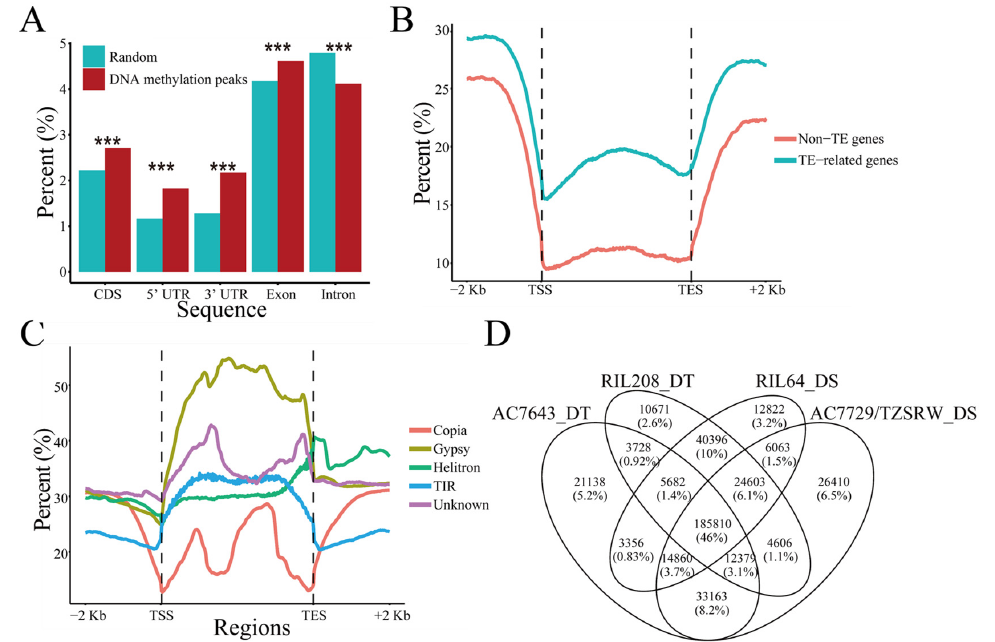
Figure 1. Summary of DNA methylation peaks. ( A ) The proportions of peaks in different genetic elements. The Y axis represents the proportions of random DNA segments and DNA methylation peaks in genetic elements. ***: p < 0.001, χ 2 test. ( B ) The distribution pattern of DNA methylation peaks around the TSS (Transcription Start Site) and TES (Transcription End Site). Non-TE genes: genes without TE-overlapping; TE-related genes: genes overlapped TE. ( C ) The distribution of DNA methylation peaks around the TSS (TE Start Site) and TES (TE End Site) in different classes of TEs. ( D ) Venn diagram comparing DNA methylation peaks in four inbred